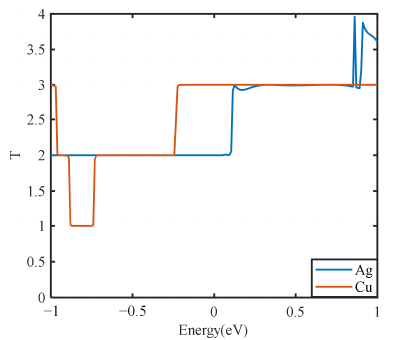
Figure 9. Transport curves of different metal electrode plates.